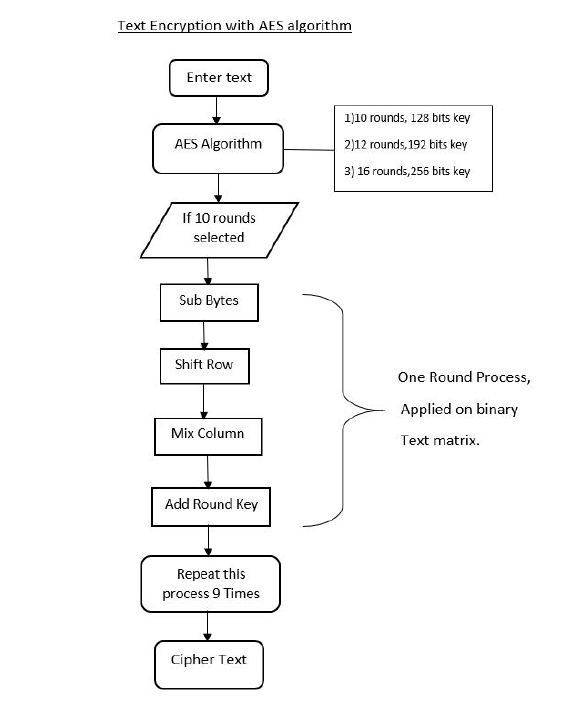
Figure 6. TEXT ENCRYPTION